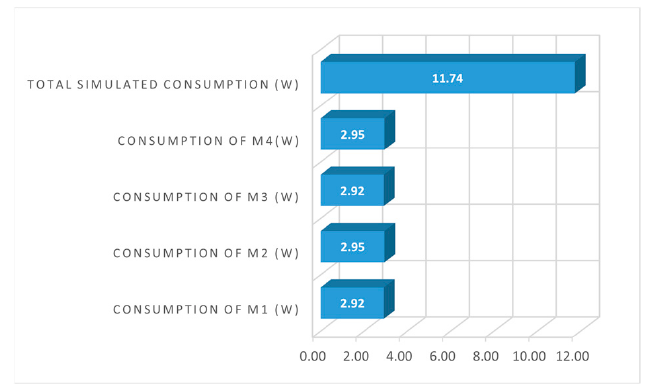
Figure 42. Power consumption—simulated in the case of the four-wheeled robot. motors and mobile robots (simulated and measured) along with the errors are presented in Table 12. It was found that the relative error of the total consumed power determined after the simulation is